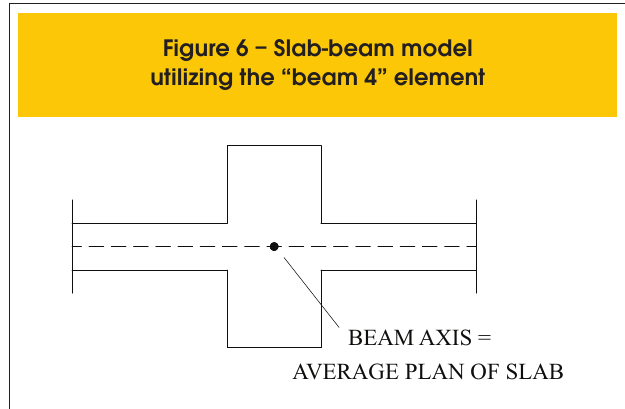
Figure 6 – Slab-beam model utilizing the “beam 4” element